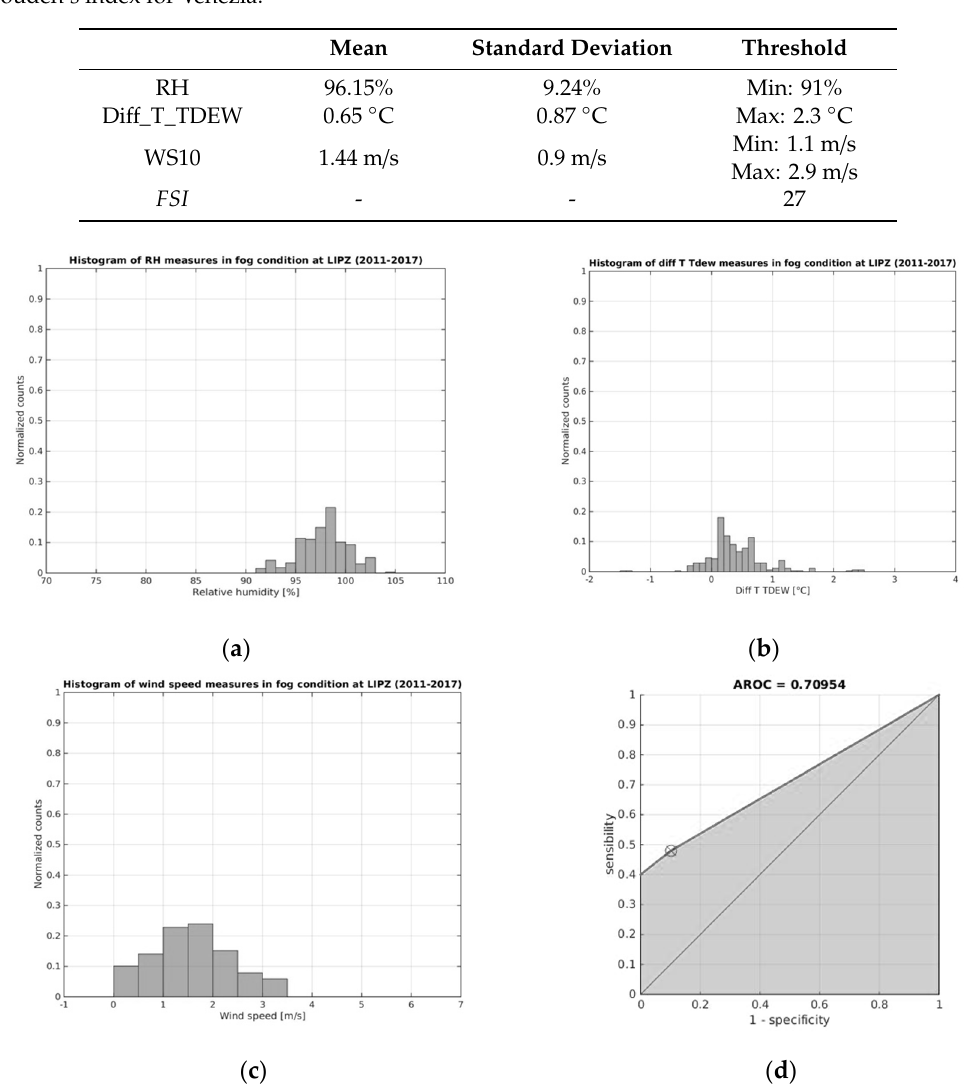
Table 9. Mean, standard deviation and thresholds selected for relative humidity, surface temperature / dew point depression and wind speed measured in fog condition and FSI threshold calculated using Youden’s index for Venezia.